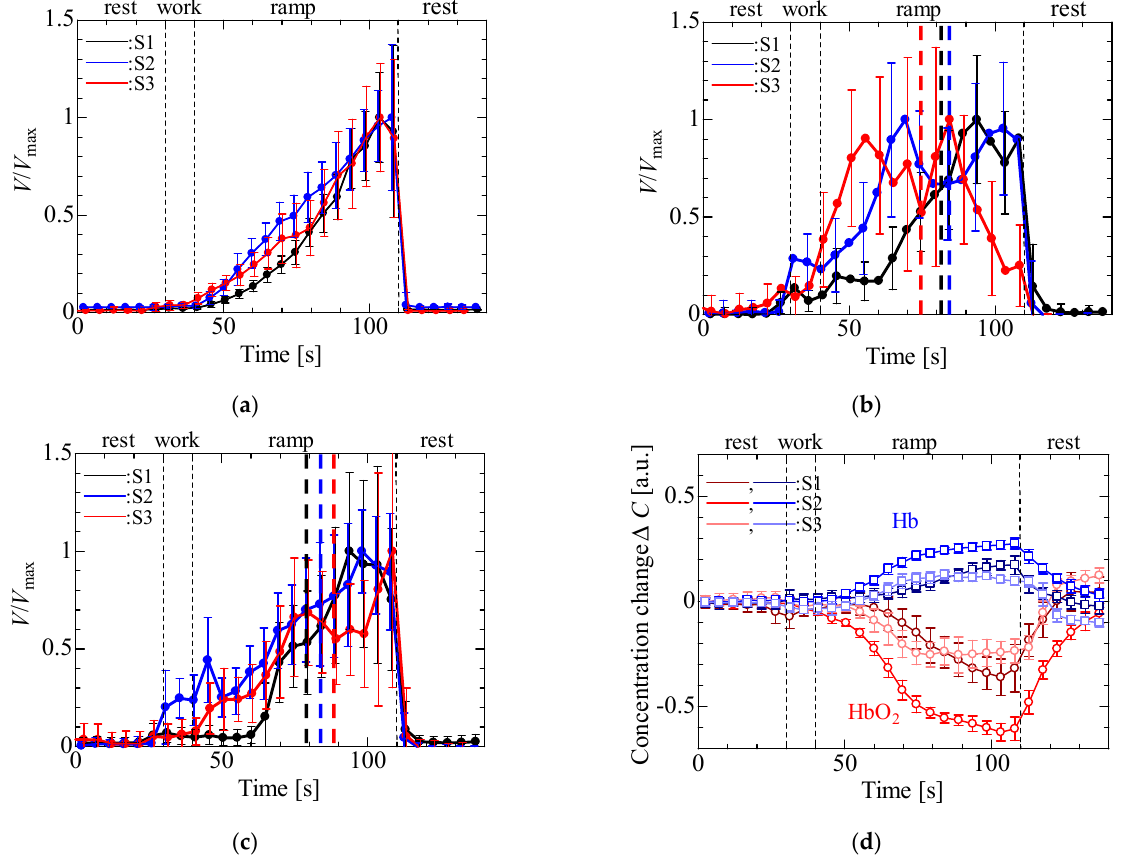
Figure 6. Experimental results for isometric ramp contraction: ( a ) EMG, ( b ) MMG (LED), ( c ) MMG (PD) and ( d ) NIRS.